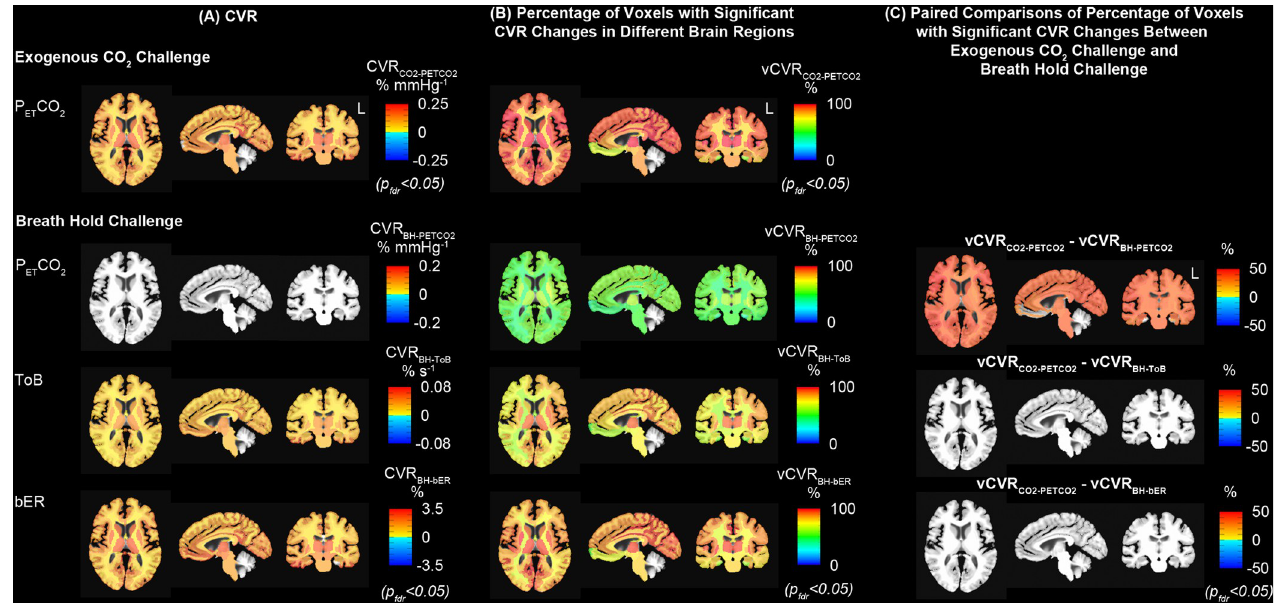
Fig 5. Comparison of group CVR maps under exogenous CO 2 challenge with those under breath hold challenge. (A) Group CVR showing significant CVR changes under exogenous CO 2 and breath hold challenges (n = 10). Group map of CVR BH-PETCO2 indicated that Δ BOLD in most of the brain regions did not associate with changes of P ET CO 2 under breath hold challenge. (B) Group vCVR maps showing percentage of voxels with significant CVR changes under exogenous CO2 and breath hold challenges for the same group of subjects (n = 10). The percentage of voxels with significant CVR changes under breath hold challenge were found in an increasing order of vCVR BH-PETCO2 , vCVR BH-ToB and vCVR BH-bER . CVR BH-bER and vCVR BH-bER showed large resemblance with CVR CO2-PETCO2 and vCVR CO2-PETCO2 respectively. (C) Paired comparisons of vCVR maps showed that vCVR CO2-PETCO2 maps under exogenous CO 2 challenge were not significantly different from vCVR BH-bER maps under breath hold challenge. Group map of vCVR BH-PETCO2 showed that Δ BOLD in only small number of voxels within the brain regions associated with the P ET CO 2 changes under breath hold challenge, resulting in significant differences found in multiple brain regions in the paired comparison between vCVR CO2-PETCO2 and vCVR BH-PETCO2 .